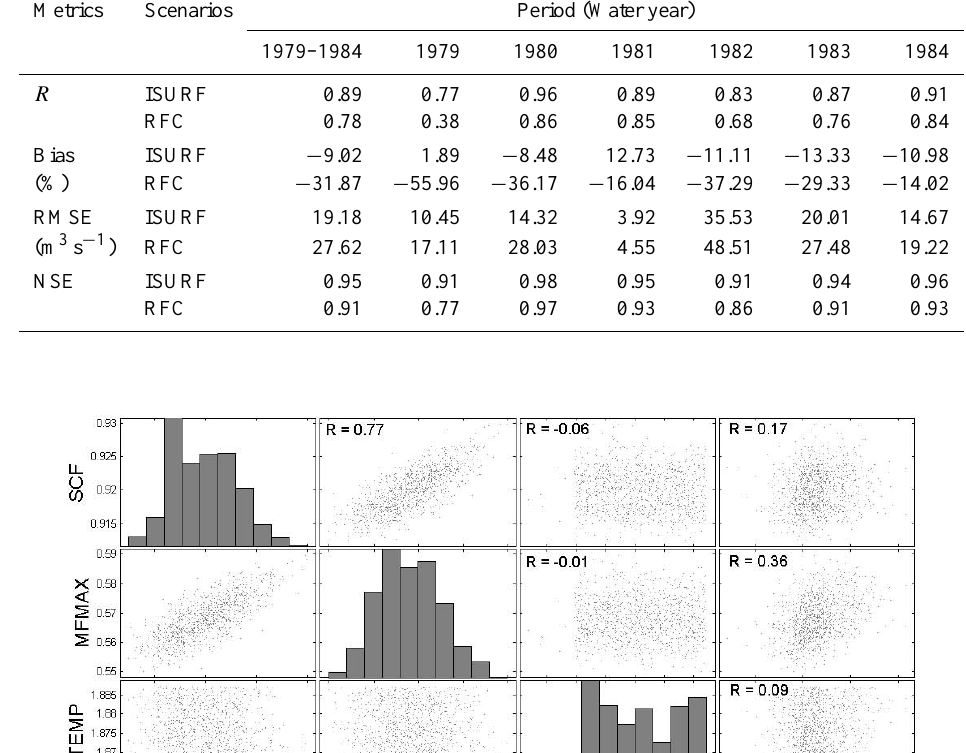
Table 4. Statistics for observed and simulated streamflow using the RFC parameters and ISURF parameters during the training period. Metrics